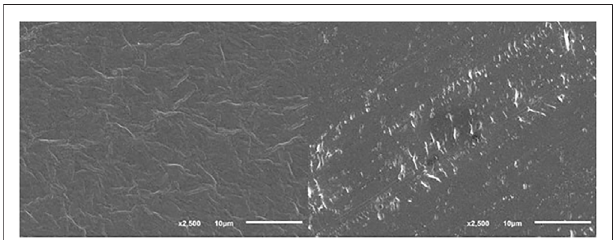
FIGURE 2 | PVC fi lm surface before (left) and after (right) biodegradation in the presence of B. amyloliquefaciens under SSF conditions; SEM conditions: SEI, WD 22, SS 30, 17